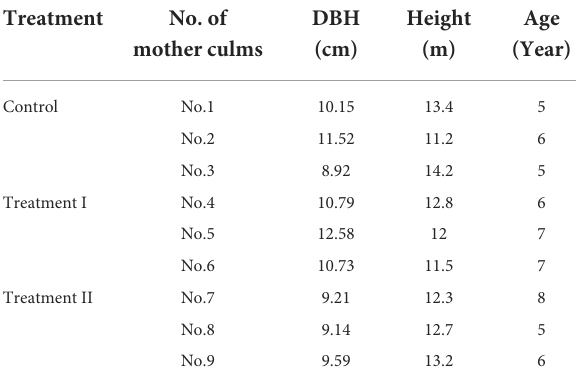
TABLE 1 Basic information of sample culms of mother bamboo.